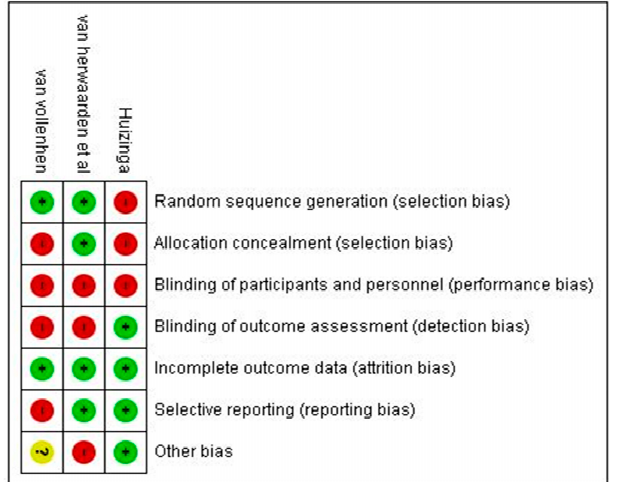
Figure 3. Risk of bias summary.